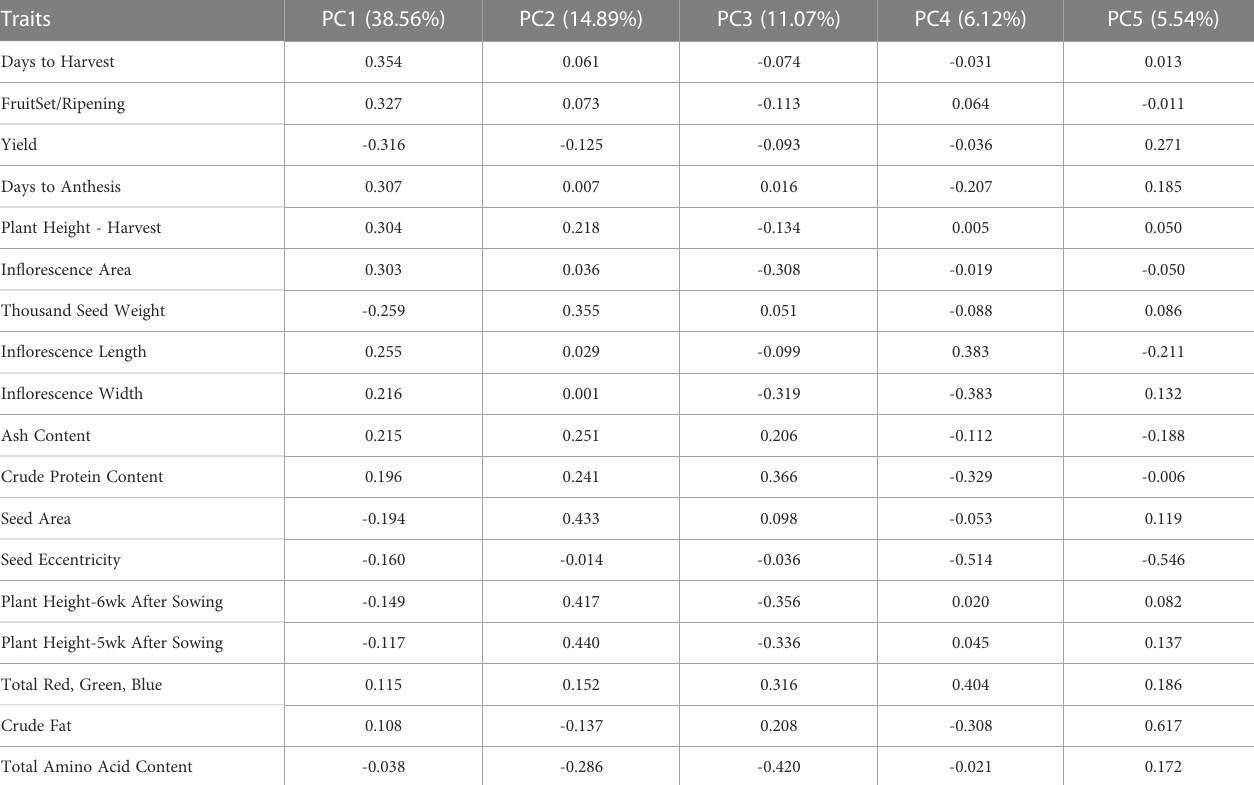
TABLE 4 Principal component analysis (PCA) results, including loadings values for principal components (PC) one through fi ve for each trait studied.